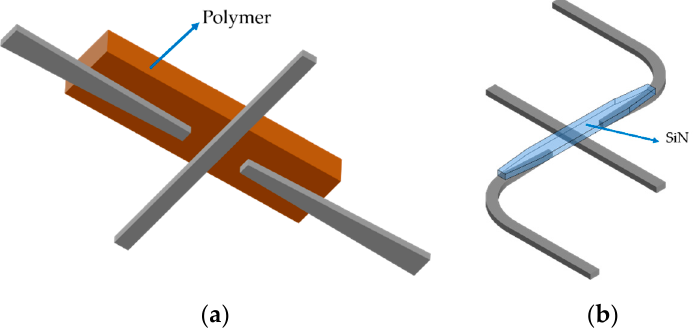
Figure 6. Schematics of the silicon waveguide crossing with vertical directional coupler consisting of ( a ) silicon and polymer layers and ( b ) silicon and SiN layers.